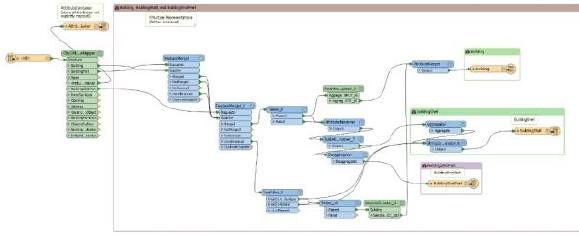
Figure 9. FME workbench to convert CityGML to I3S.